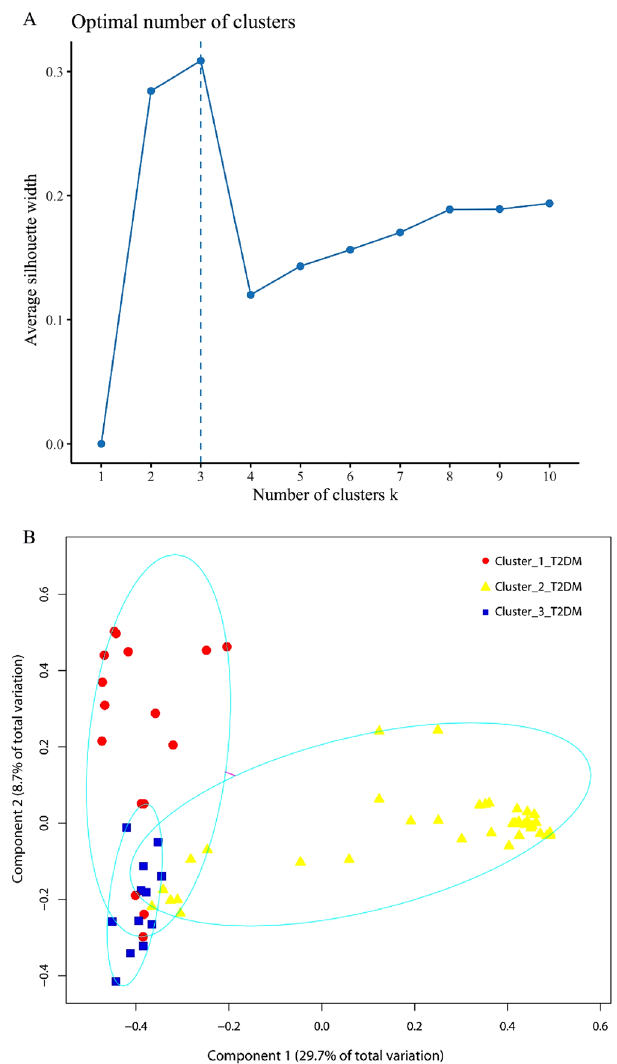
Figure 1. Clustering of the genitourinary microbiomes in T2DM patients by ( A ) average silhouette analysis and ( B ) partition around medoids clustering analysis, into three clusters of T2DM microbiomes, i.e., Cluster_1_ T2DM, Cluster_2_T2DM and Cluster_3_T2DM. Note: the analyses were performed in R version